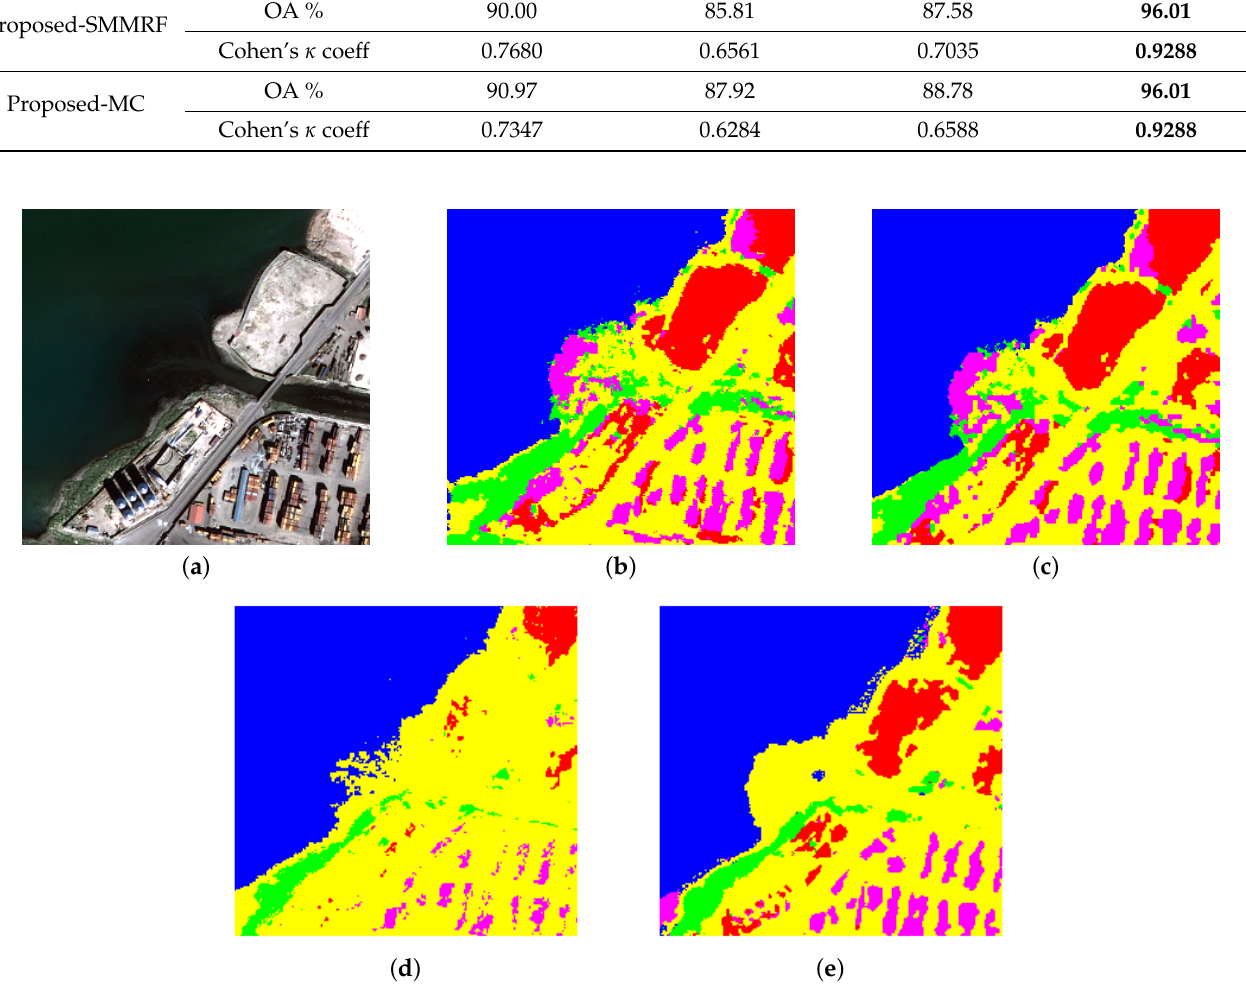
Figure 7. “Haiti” dataset: details of ( a ) the 1.25 m resolution image and of the classification maps generated by ( b ) the proposed SMMRF-based algorithm with GBRT, ( c ) the proposed MC-based algorithm with the zig-zag and Hilbert curve scan and GBRT, ( d ) the single-resolution MRF-based classifier after resampling, and ( e ) the adaptation of the technique in [75] to the case of optical-SAR data. Color legend for the classes: containers , vegetation